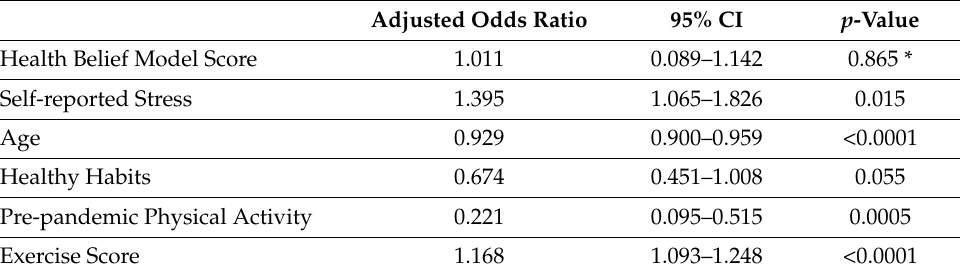
Table 3. Health Belief Model and Nutrition Behavior Change: Binary Logistic Regression Model.